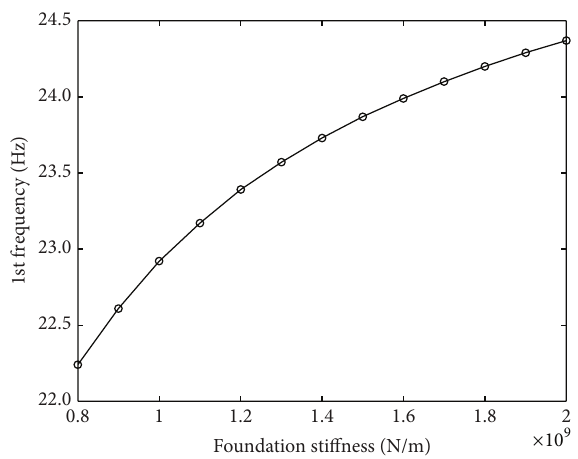
Figure 12: Effect of foundation stiffness on the 1st natural frequency.